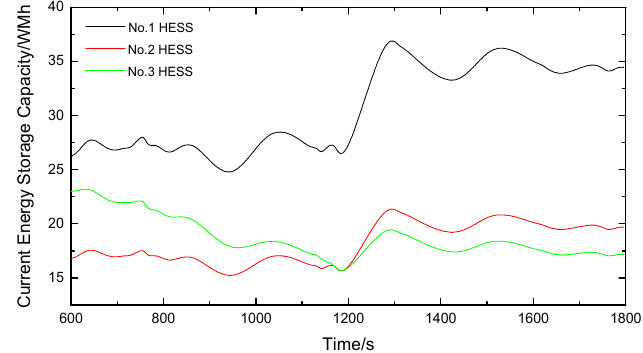
Figure 7. Current energy storage capacity changes for different HESS.